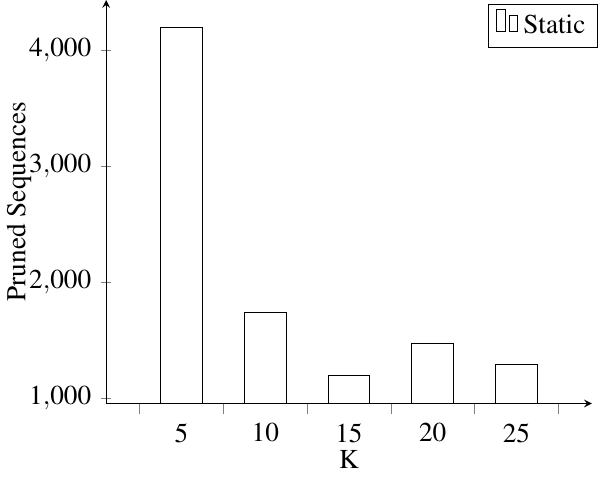
Fig. 14. Effect of k on node pruning